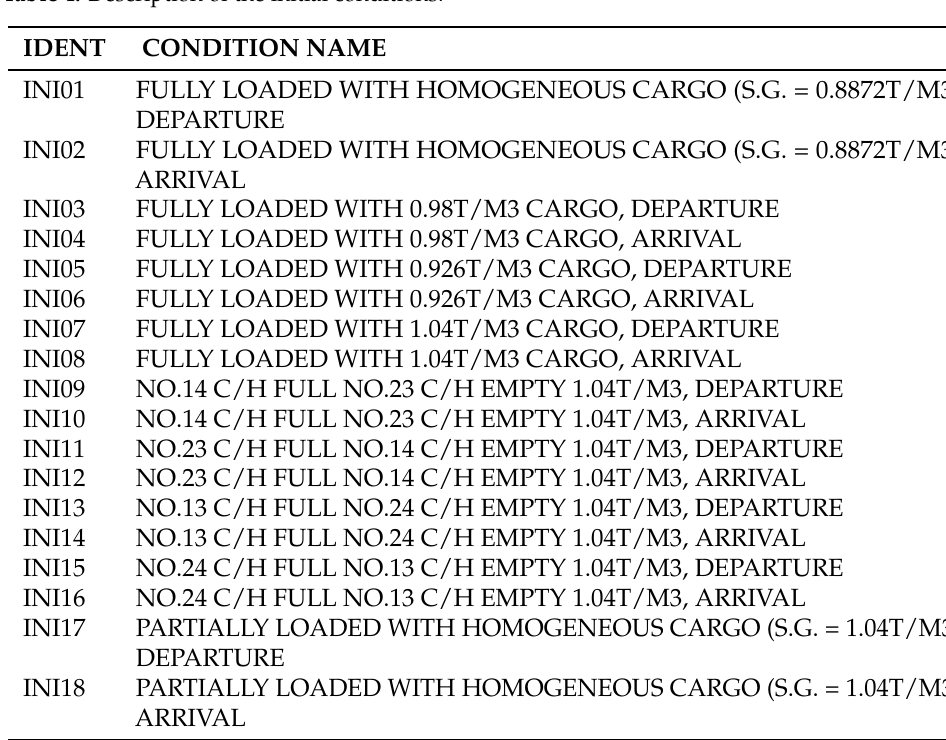
Table 4. Description of the initial conditions.